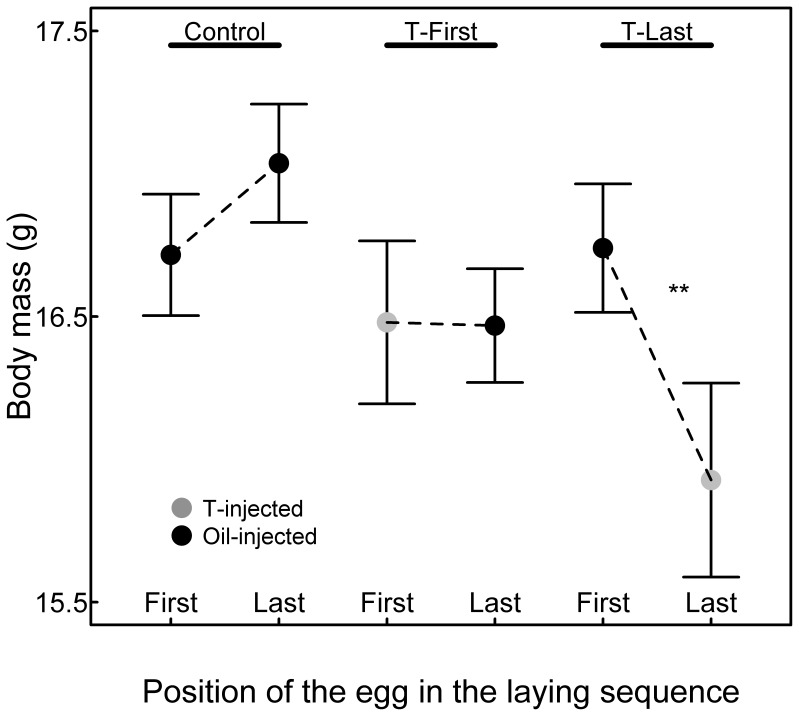
Body mass (mean ± SE) of chicks in relation to the laying position and treatments.Grey points indicate body mass of chicks hatched from T-injected eggs. Black points indicate body mass of chicks hatched from oil-injected eggs.